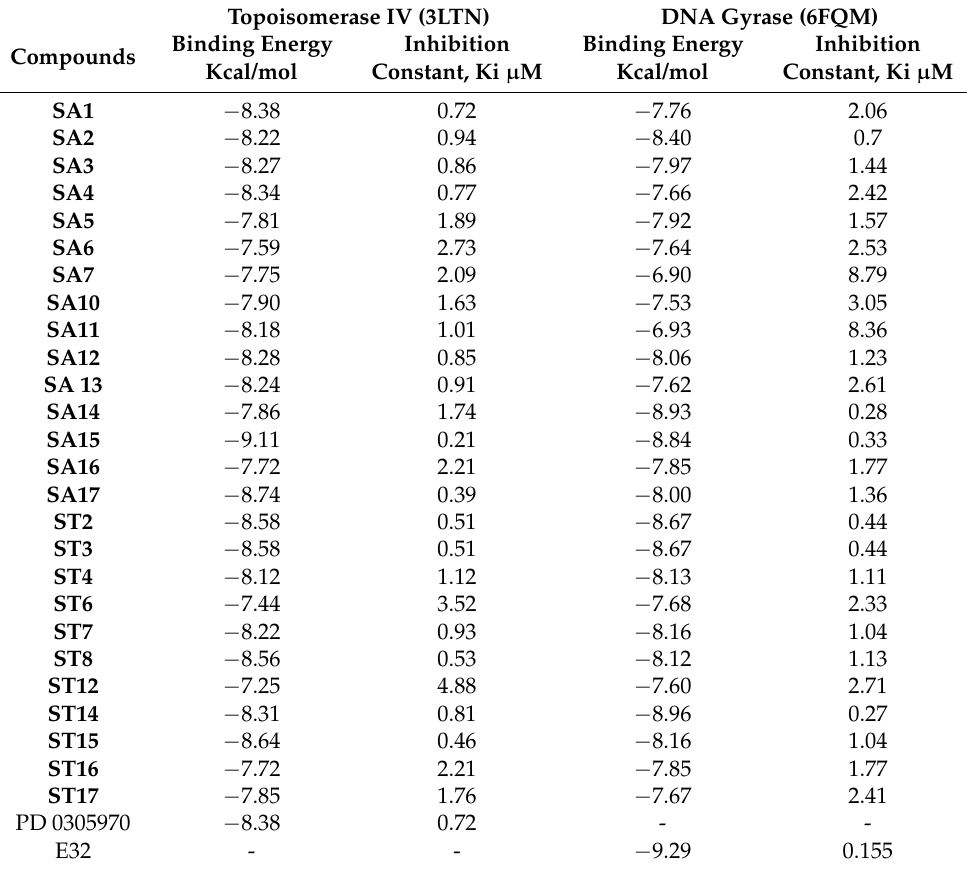
Table 2. Calculated binding energies and inhibition constants for synthesized compounds. Topoisomerase IV Compounds